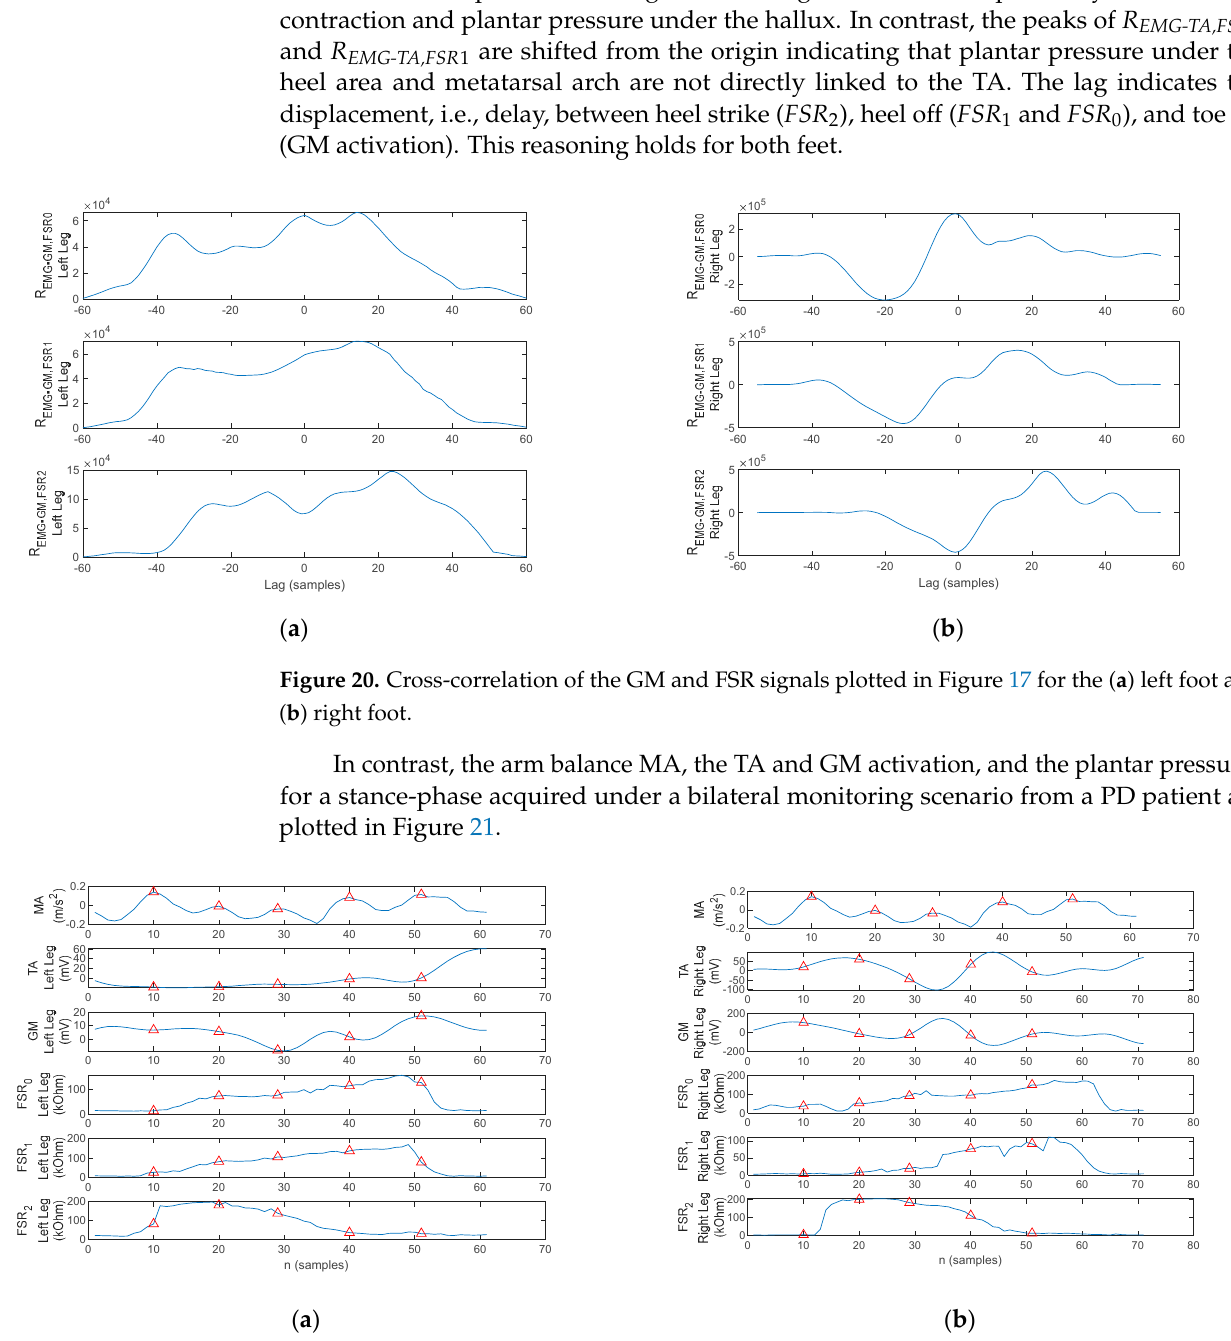
Figure 21. One-stance gait section plot of the arm balance MA, EMG of the TA and GM, and FSR signals for a PD patient, with the red triangles indicating the MA maxima: ( a ) left foot and ( b ) right foot.